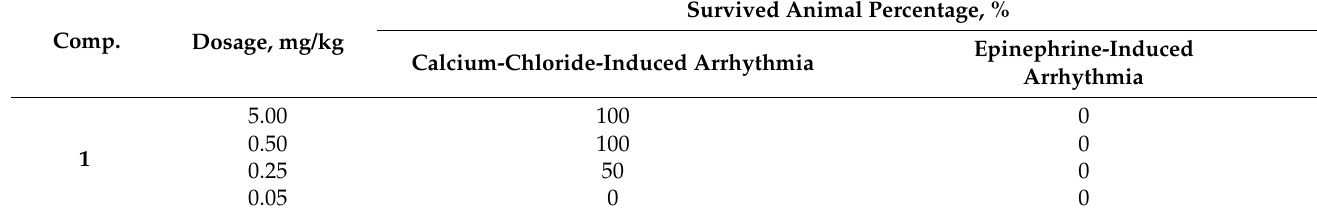
Table 10. Antiarrhythmic activity of compound 1 .